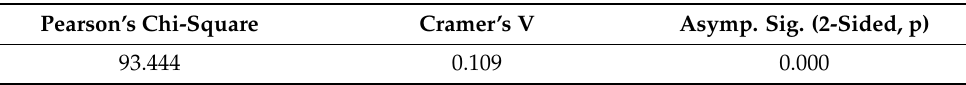
Table 5. The statistical relationship values for relation between the number of classes and the per ‐ ceived importance of environmental protection.